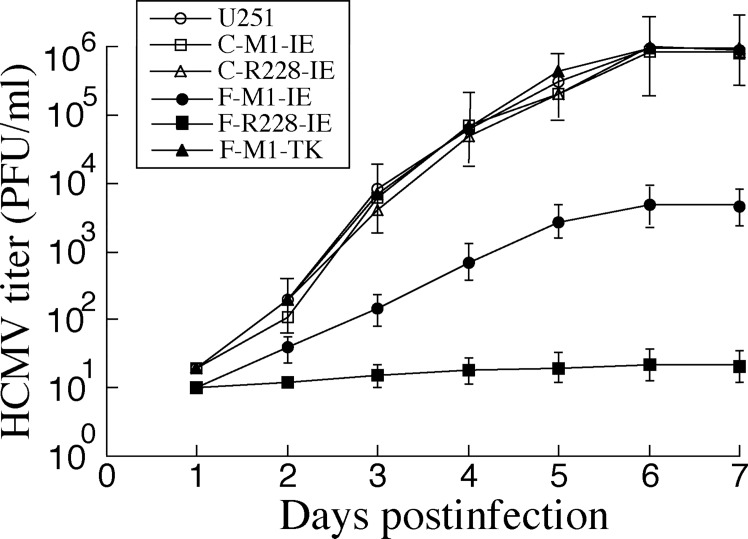
HCMV production in U251 cells and ribozyme-expressing cells.Experimental details were described in Methods. We performed the assays in triplicate and repeated the assays three times.